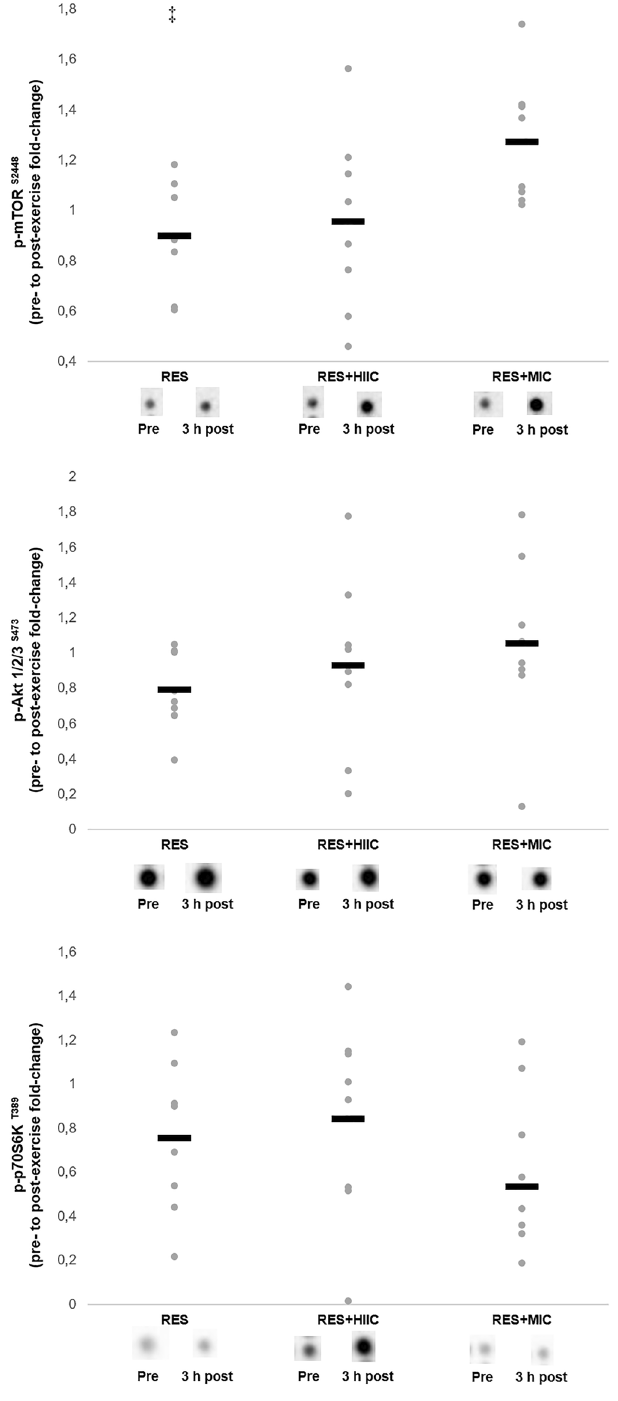
Figure 2. Individual and mean responses in phosphorylation of the mTOR signaling pathway in the RES, RES + MIC, and RES + HIIC conditions including representative images. Grey dots represent individual responses and black lines represent the mean. ‡, significantly different from RES + MIC condition ( p < 0.05). In all instances all samples from 8 participants were available for